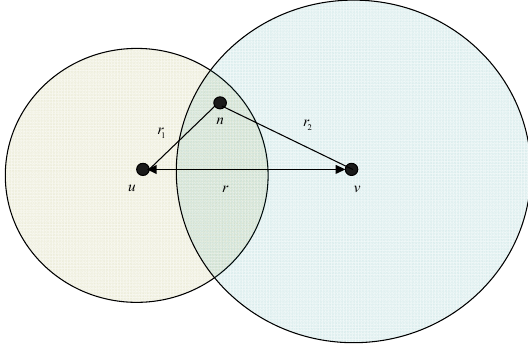
Figure 15. Transmission range adjustment in energy ‐ efficiency analysis.